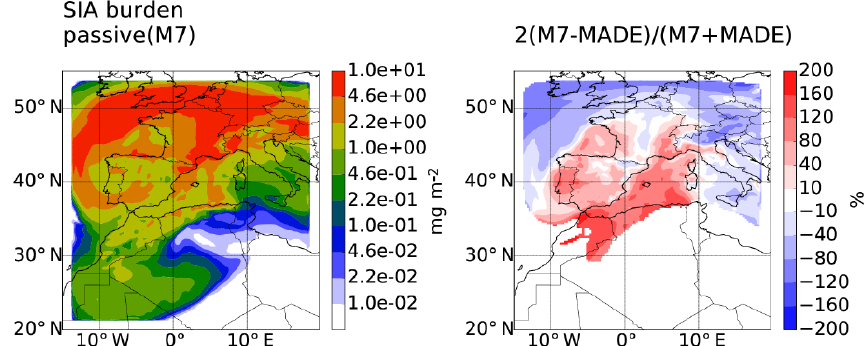
Figure 8. SIA burden for default setups. This figure corresponds to SO 4 in Fig. 3 but shows SIA for the Passive simulations. SIA corresponds to SO 4 for M7 and additionally includes NO 3 and NH 4 for MADE.